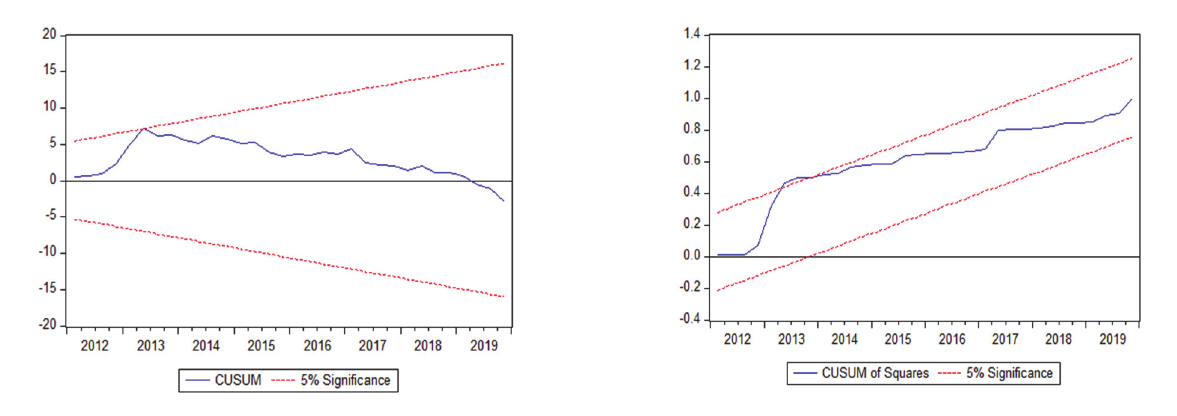
Fig. 6. CUSUM and CUSUM of Square for ARDL Model of Transport and